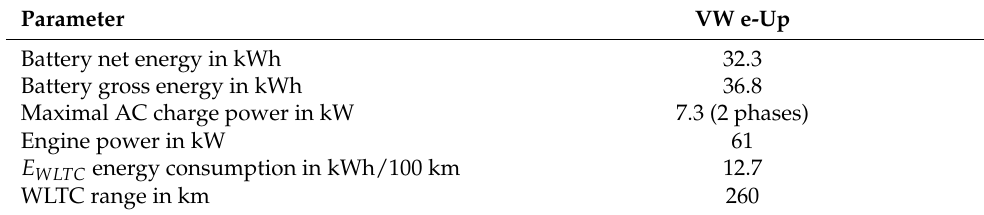
Table 2. Relevant vehicle data.